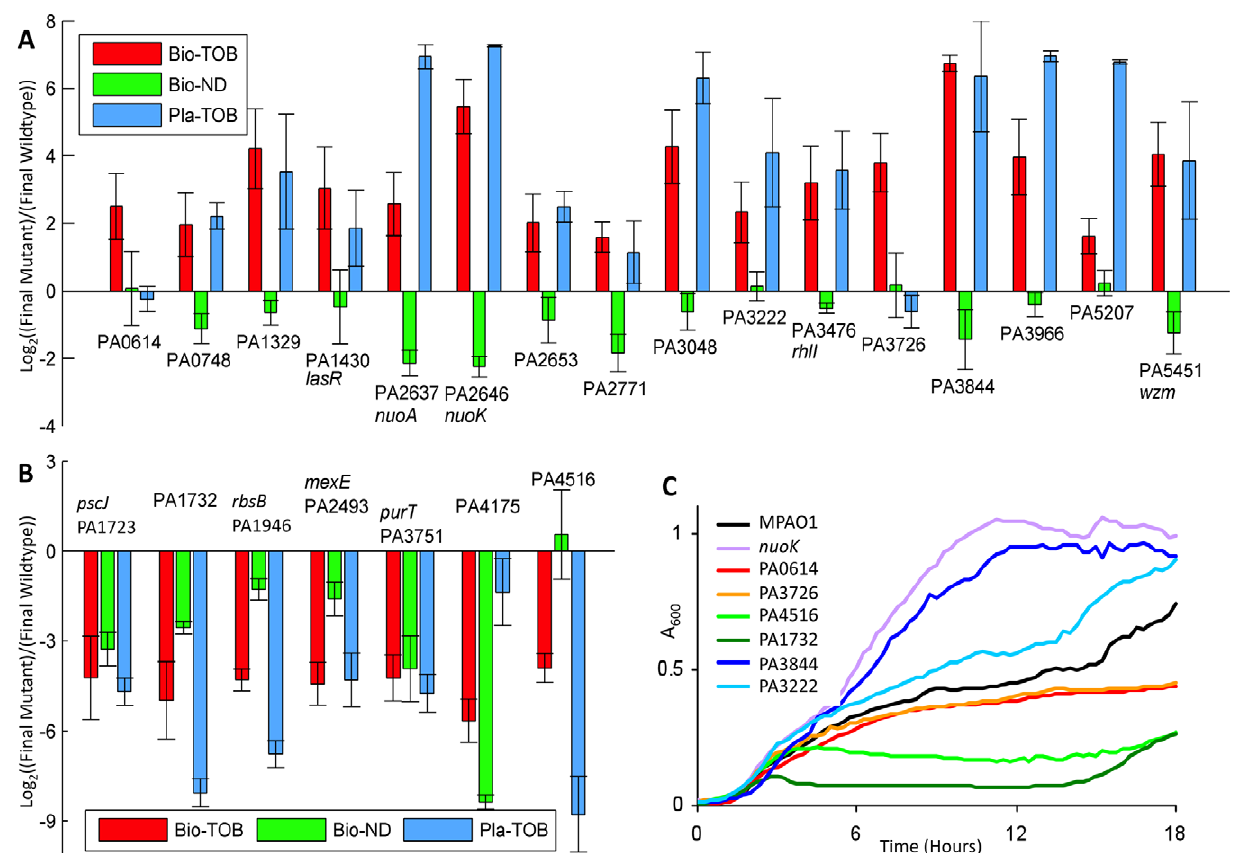
Figure 3. Fitness characterization of candidate mutants in different physiological states. (A, B) Competitions were started with equal amounts of mutant and reference cells. The y-axis indicates the relative count of mutants over the reference strain following one round of the indicated experimental challenge (as explained in Materials and Methods). As cultures undergo different numbers of generations during each type of challenge, values from different challenges for the same mutant are not directly comparable. Error bars indicate the standard error of at least 8, 4, and 3 experiments for the Bio-TOB, Bio-ND, and Pla-ND conditions, respectively. Mutants in (A) have an advantage over wild-type in the Bio-TOB competition; mutants in (B) have a disadvantage. Gene annotations, which were updated from the original genome annotation [48] by BLAST comparisons [14] against the NCBI non-redundant database, are in Table S3. (C) Growth curves for representative strains from panels (A) and (B) with 4 m g/ml tobramycin are